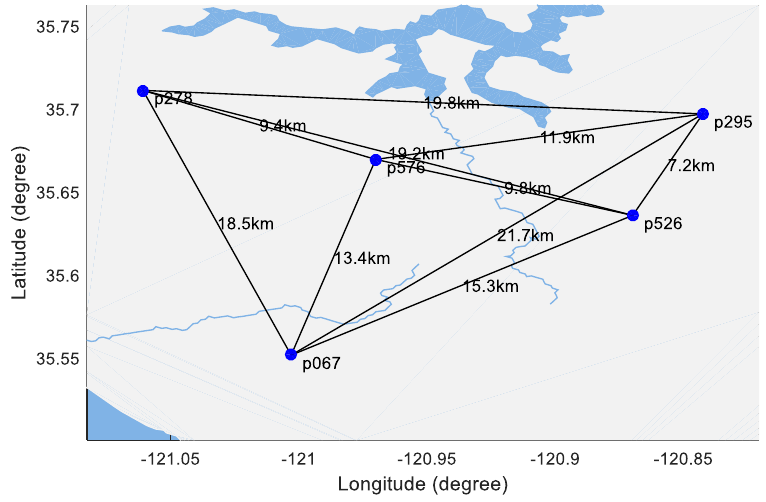
Figure 9. Illustration of the network of five GPS stations for data analysis.